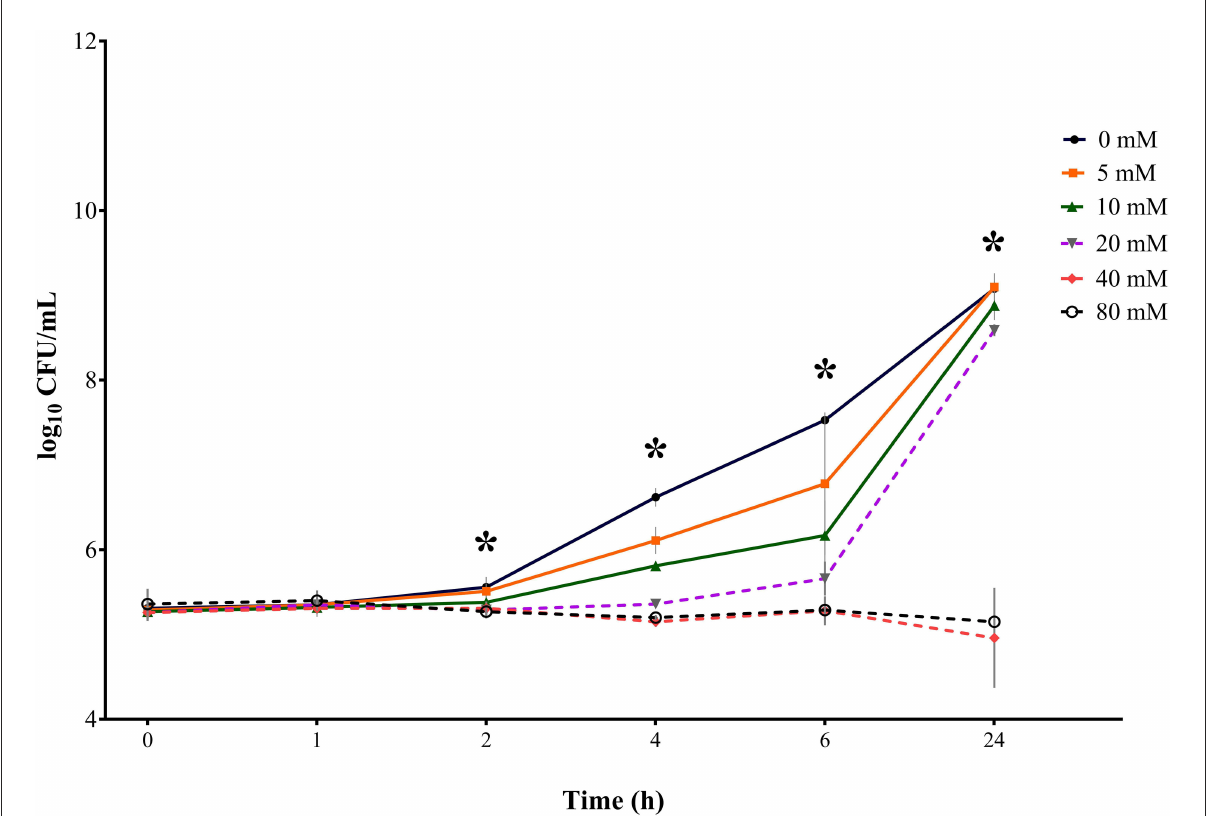
FIGURE5 Bacterial growth curves (log 10 CFU/mL) for S . Typhimurium for three consecutive trials ( n = 3) for sodium butyrate (SB) concentrations 0, 5, 10, 20, 40, and 80mM and incubation times 0, 1, 2, 4, 6, and 24h; * indicates significant difference between concentrations ( p < 0.05).